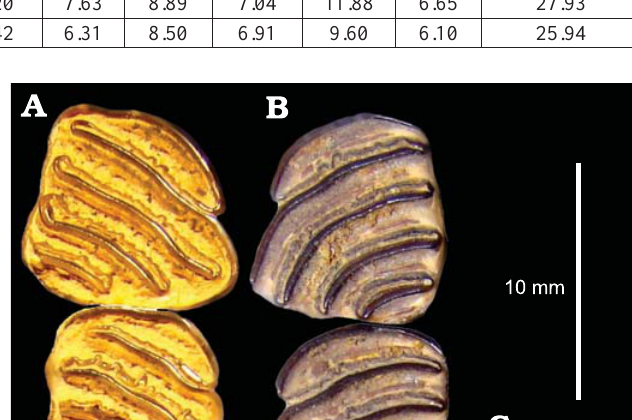
Potamarchus sp . UFAC